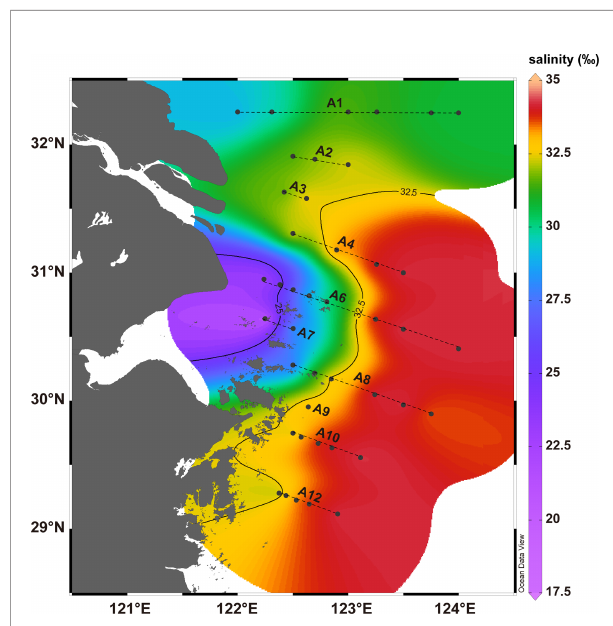
FIGURE 1 | Map of the study area with 42 sampling sites and the spatial distribution of salinity of bottom water in the East China Sea (Ocean Data View